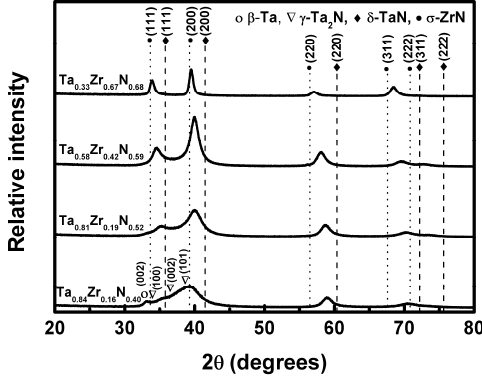
Figure 2. XRD patterns of as-deposited Ta–Zr–N thin films prepared on Si substrates.